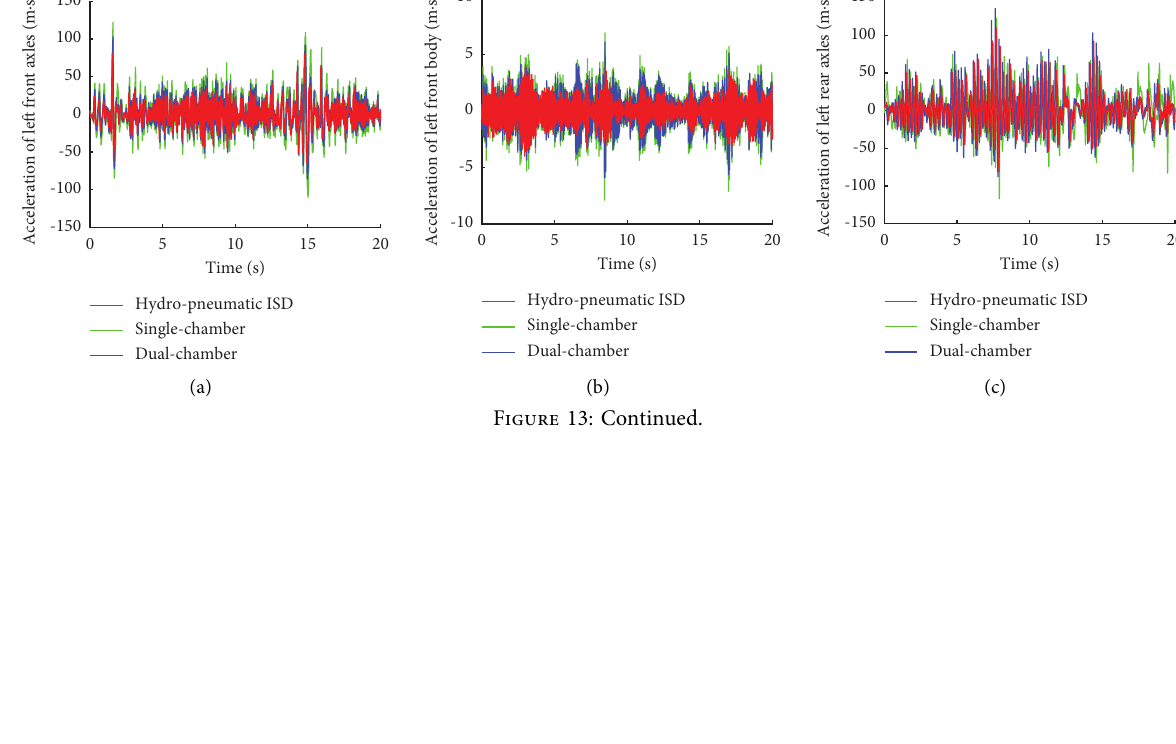
Figure 12: Comparison of pulse input test results.